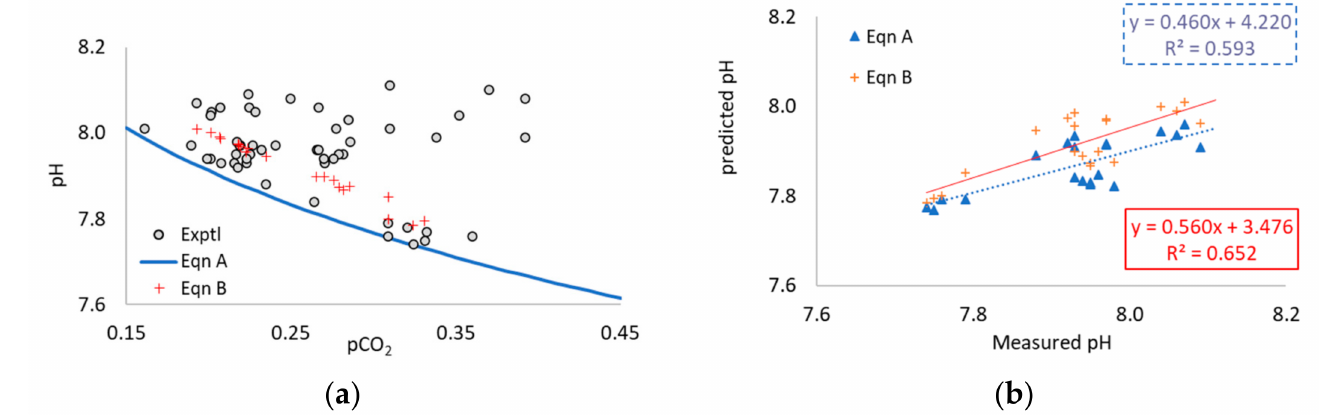
Figure A4. ( a ) Measured pCO 2 and measured and predicted pH values and ( b ) predicted pH values from Equations A and B for thermophilic CO 2 biomethanisation of cattle manure and whey using modelled TAN values associated with Lovato et al. [39]. See Table S7 for operating conditions and average results for each